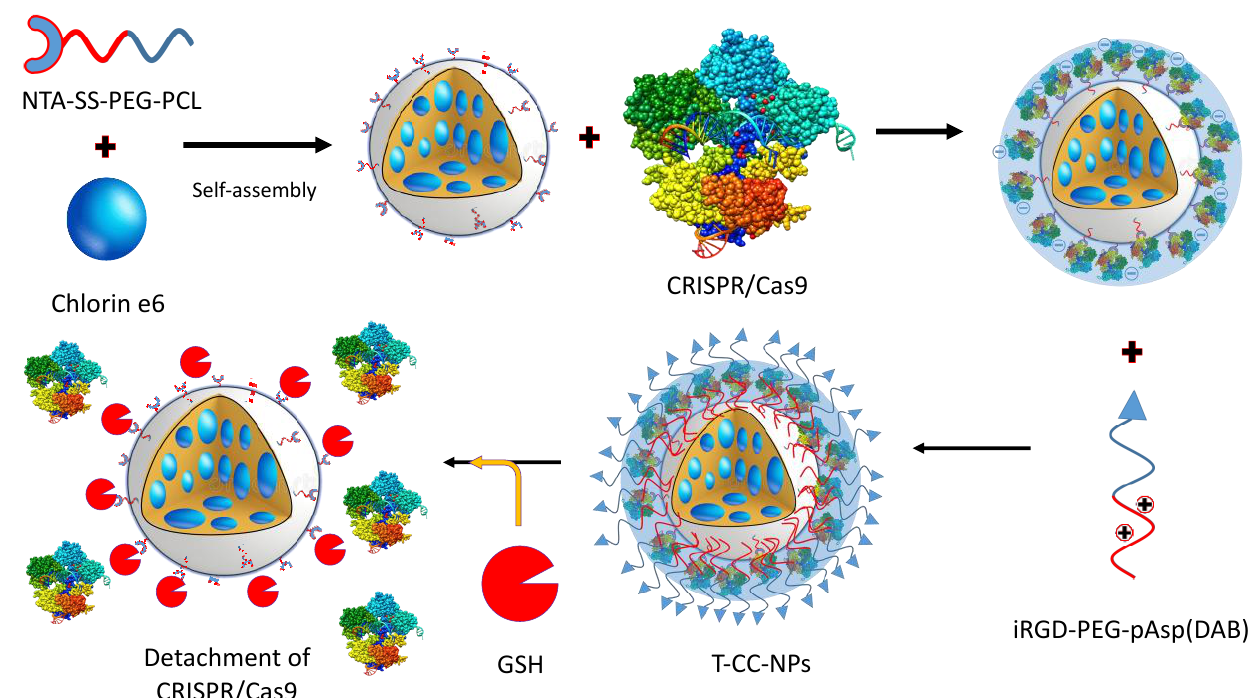
Figure 9. Diagrammatic illustration of reducing agent-sensitive nanoformulation containing Nrf2- targeting CRISPR/Cas9.